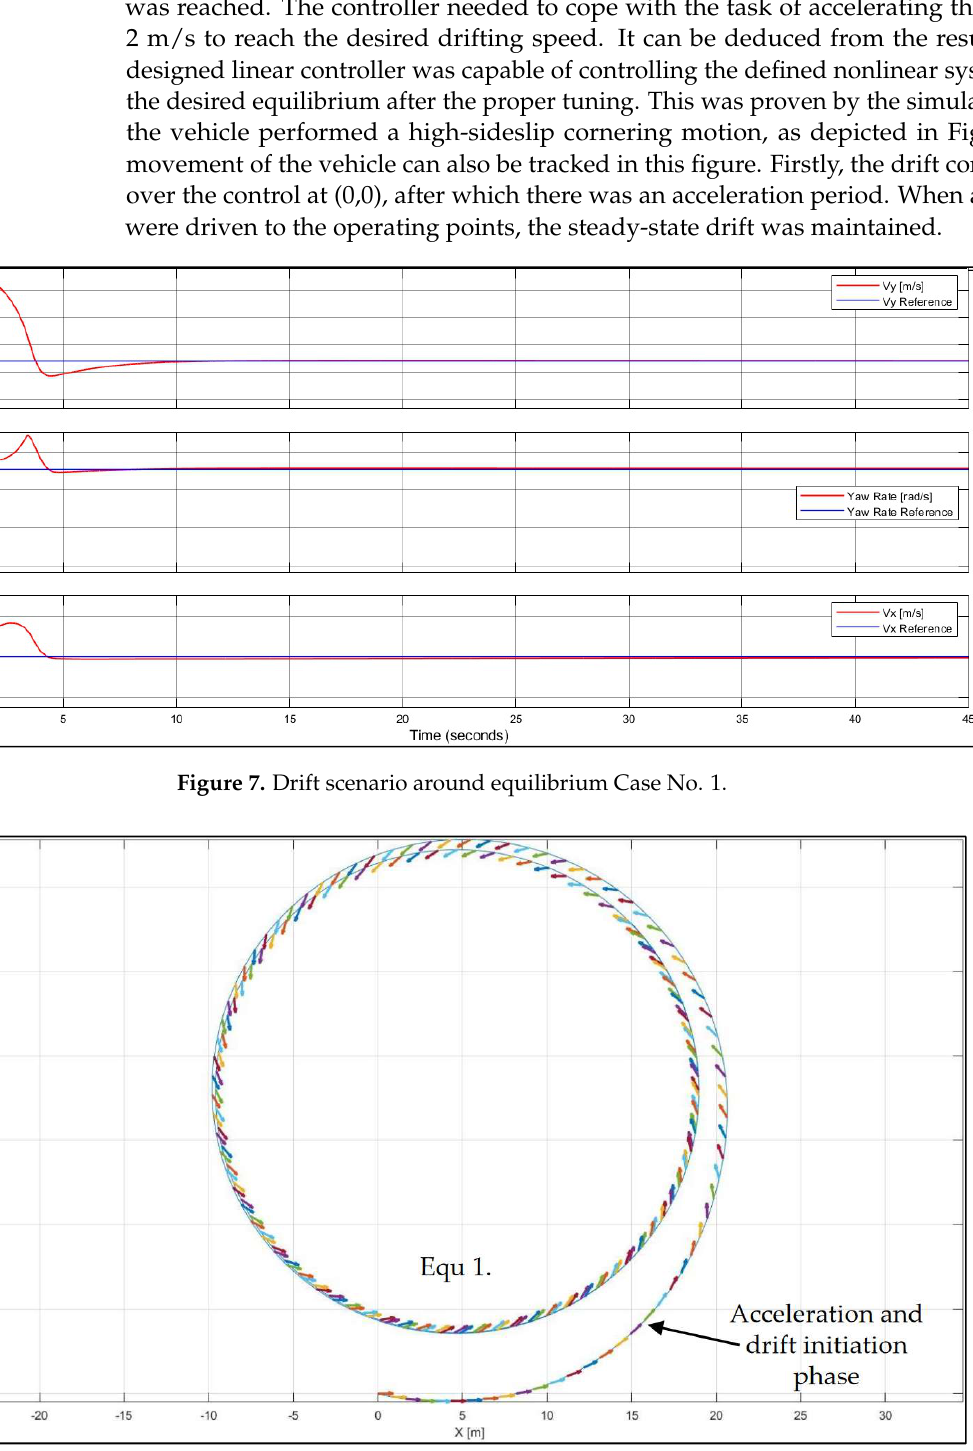
Figure 8. The heading of the vehicle during steady-state drift in equilibrium Case No. 1.